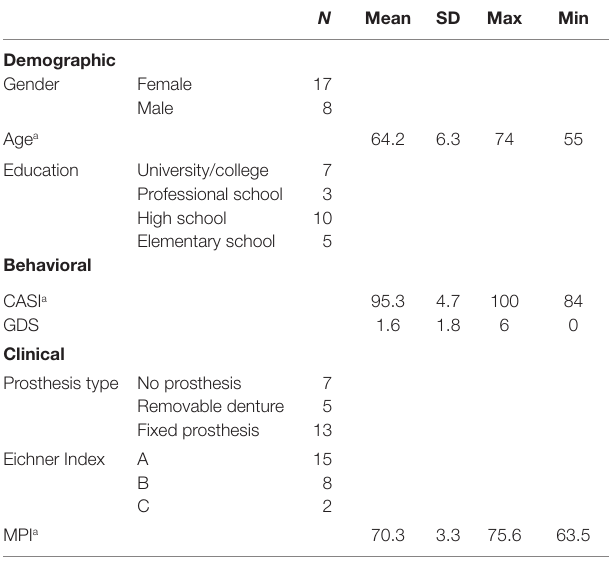
CASI, the Cognitive Abilities Screening Instrument; GDS, the Geriatric Depression Scale-short form (GDS); MPI, Masticatory Performance Index; N, number